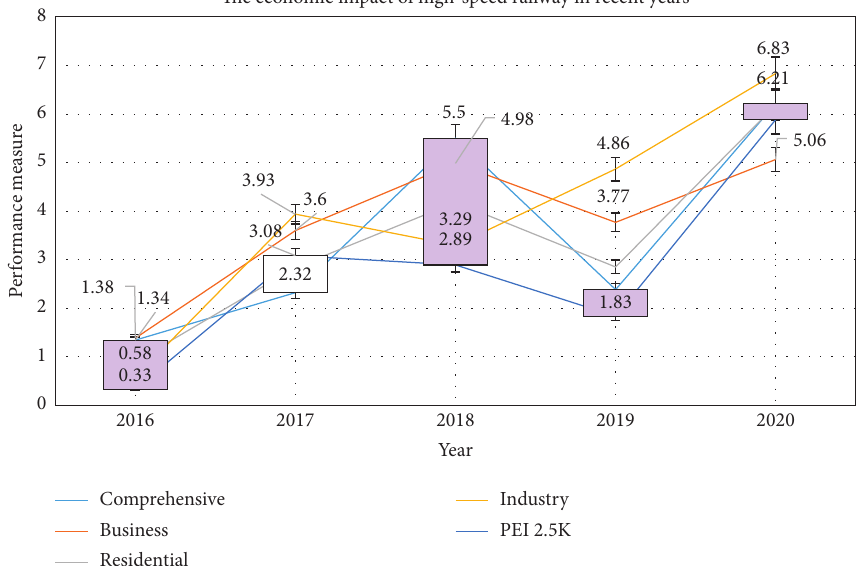
Figure 7: The economic impact of high-speed railway in recent years.